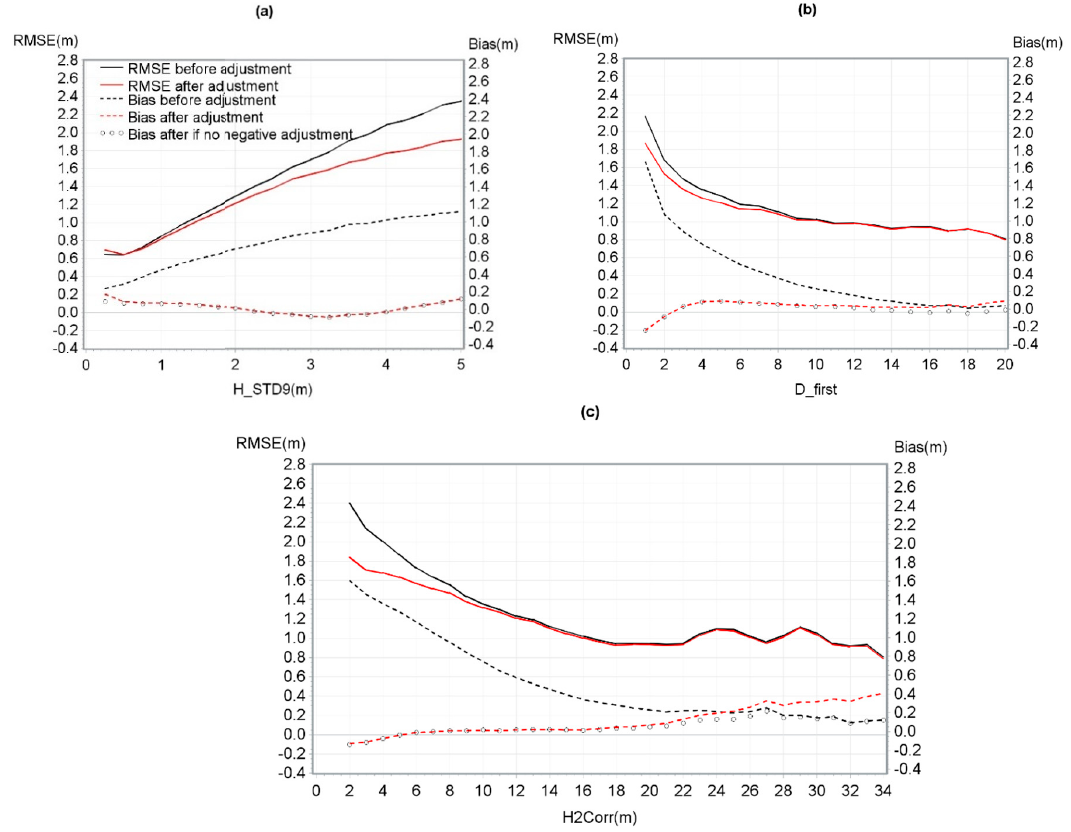
Figure 8. RMSE and mean bias of the CHM model based on (a) H_STD9, (b) D_first, and (c) H2Corr.